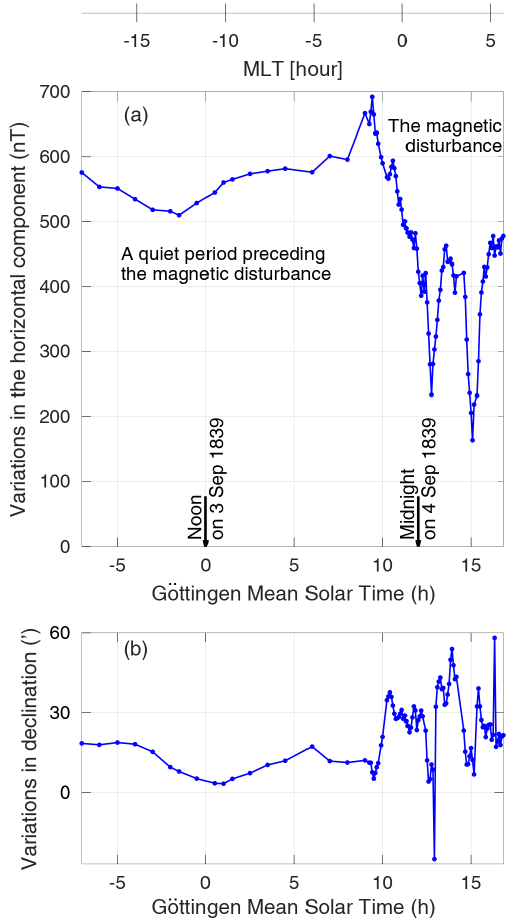
Figure 7. The first storm that was registered at Clementinum. It commenced on 3 September 1839 in the evening. (a) There were two sharp and deep depressions of the horizontal intensity that oc- curred after midnight on 4 September 1839 at 12:45 and 15:05 (Göttingen mean solar time). These moments correspond to mag- netic local times 01:39 and 04:59, respectively. Judging from their shapes and from the fact that they happened at night, these two swift disturbances might probably have been substorms. The figure also demonstrates the procedure with which the magnetic storms were commonly registered that time, i.e. shortening the time interval be- tween readings of the values from the variation instruments imme- diately after an interesting magnetic variation commenced, as de- scribed in Sect. 2.3. Panel (b) displays the course of (eastern) decli- nation during the same period.